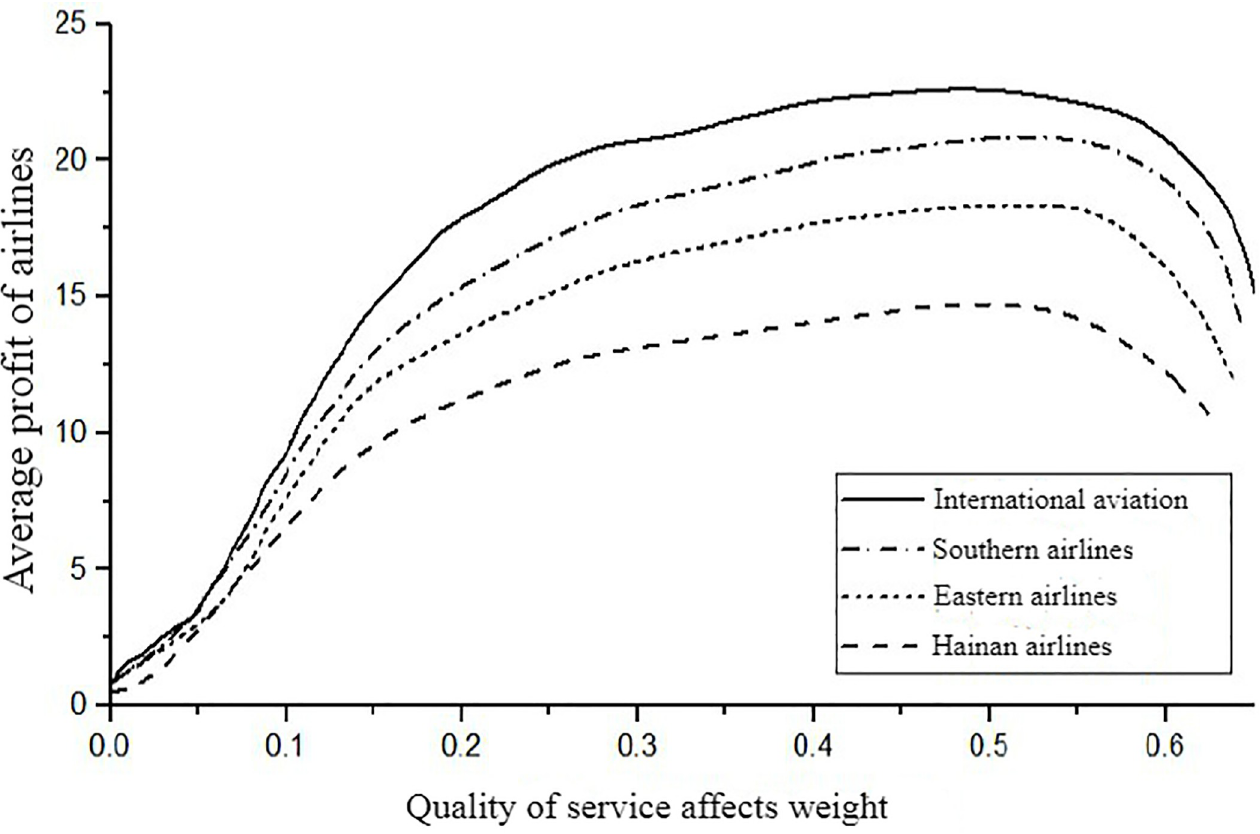
Fig 6. At T = 35, the effect of the β 4 change on average